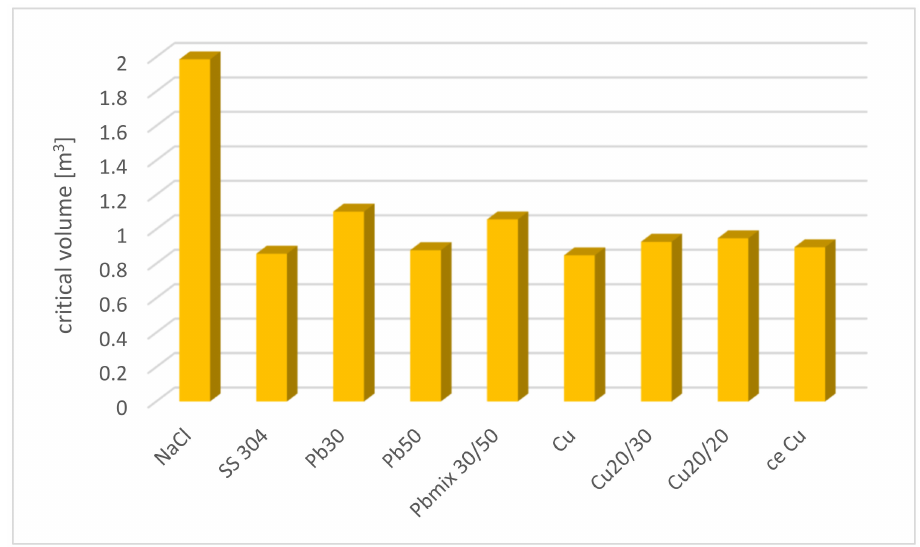
Figure 16. Evaluation of the required core volume to achieve a critical core, depending on the chosen reflector